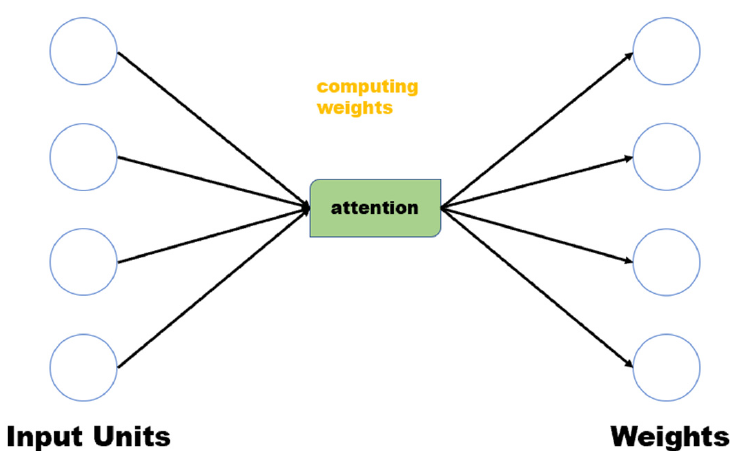
Figure 3. The key currency principle of attention layer.